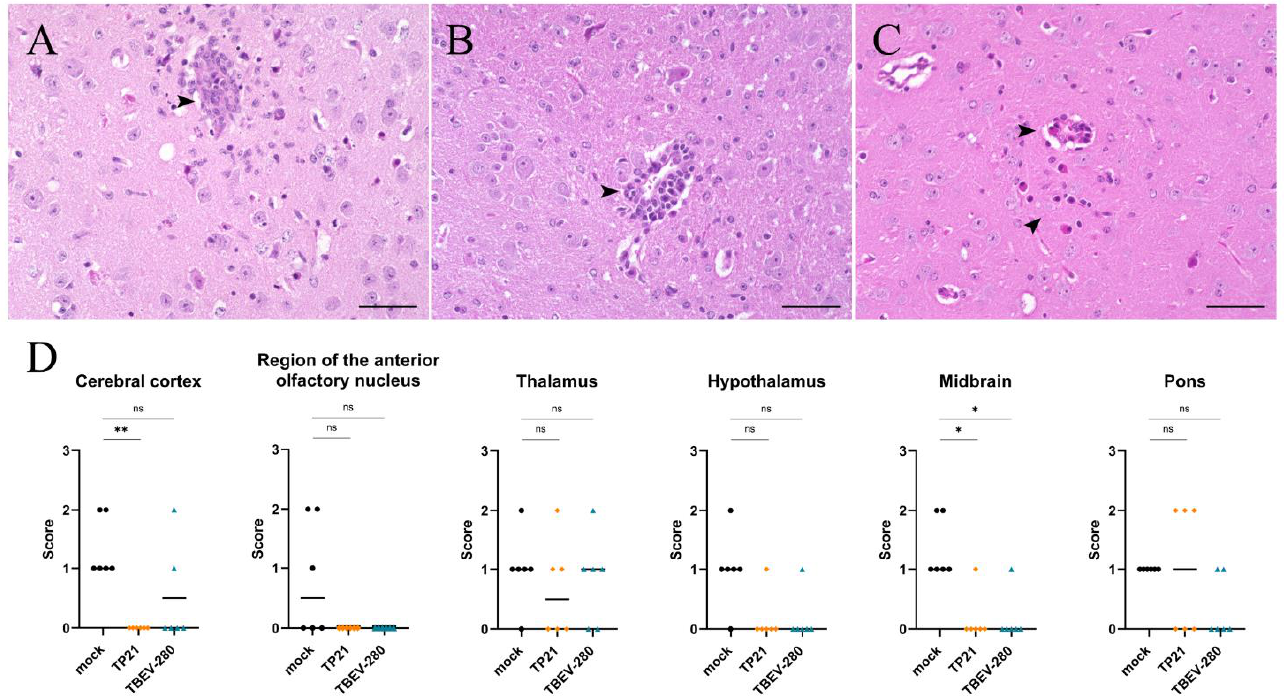
Figure 5. Inflammation in the brain. Regions with perivascular infiltrates (PVI) were assessed using HE staining. PVI (arrow heads) were not only detected in mock ( A ) but also in TP21 ( B ) and TBEV-280 ( C ) immunized mice that were subjected to TBEV-Hypr challenge; scale bars 50 µ m. ( D ) High power fields from different regions of brain of mock ( • ), TP21 ( (cid:7) ) and TBEV-280 ( (cid:78) ) immunized mice ( n = 6) were screened and the score (see methods) obtained for PVI from individual mice was plotted here. Dots representing individual animals, bars indicating mean value (* p < 0.05; ** p < 0.01, ns = not significant).